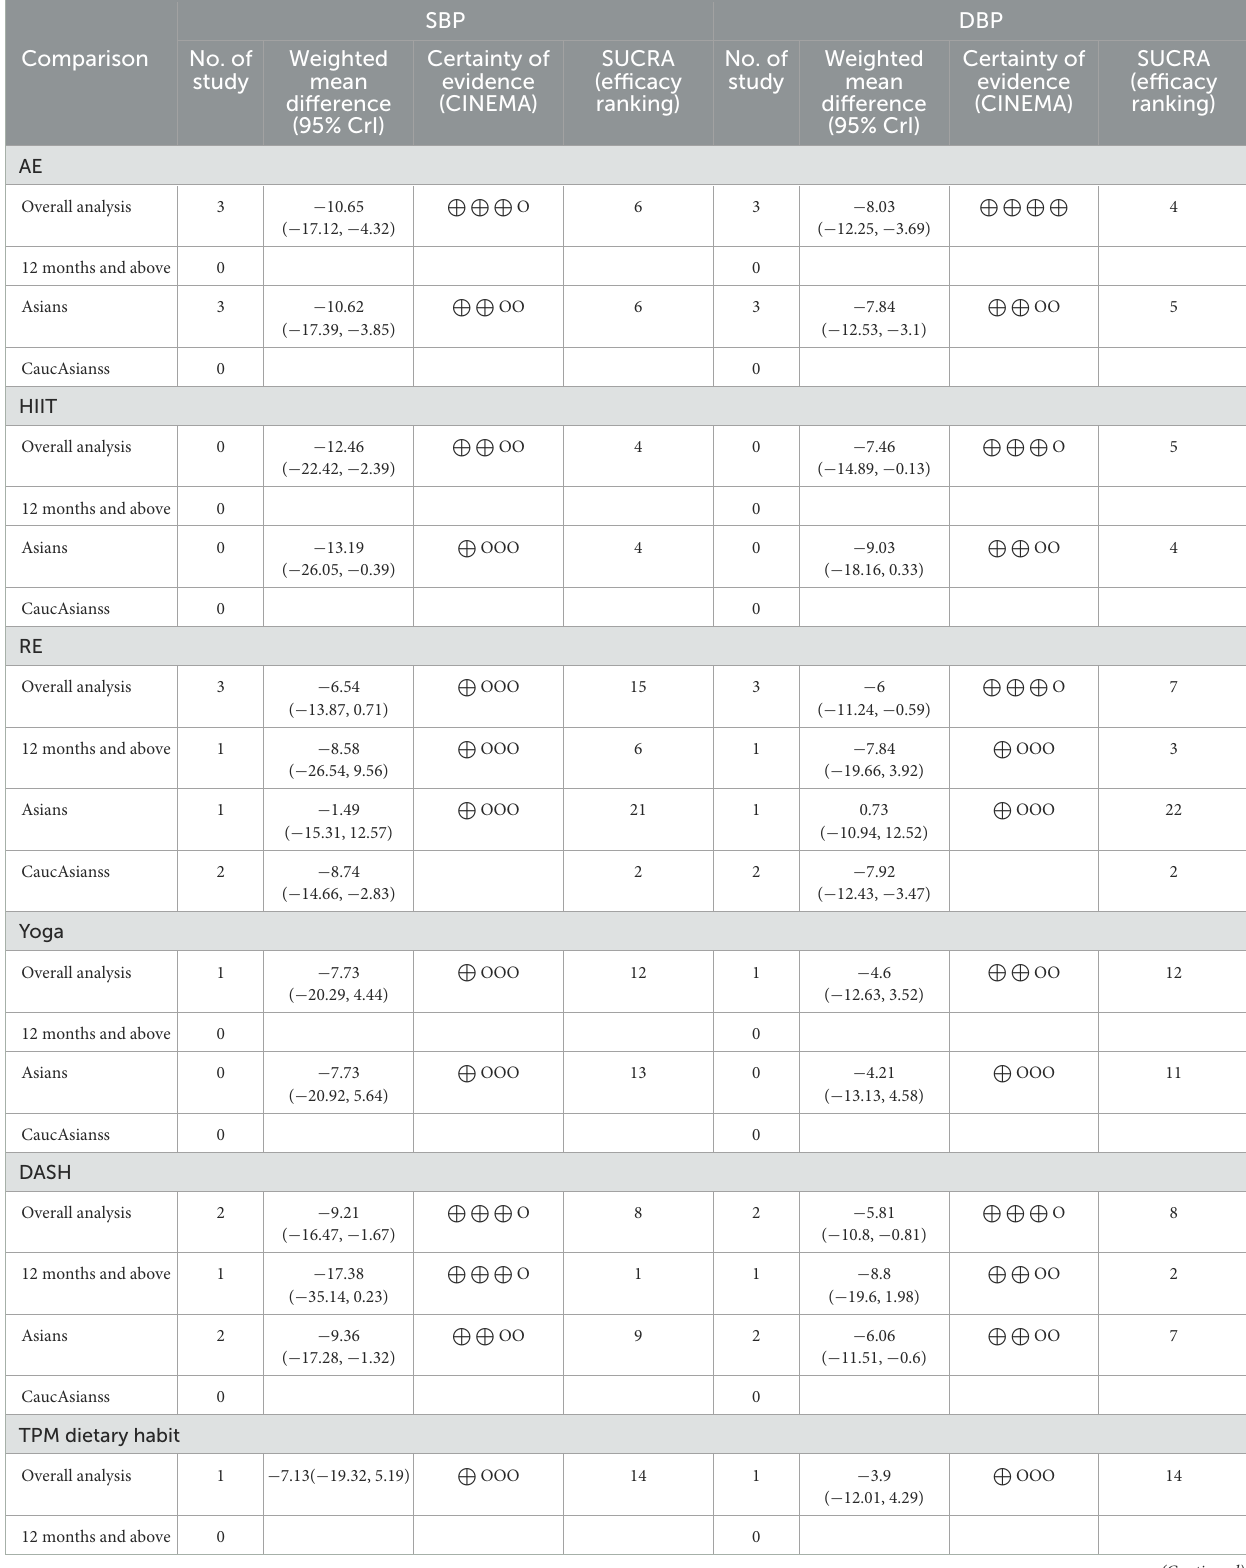
TABLE 3 Subgroups analysis of SBP and DBP based on prolonged intervention and different ethnic and cultural backgrounds (Asian, Caucasian). Comparison No. of